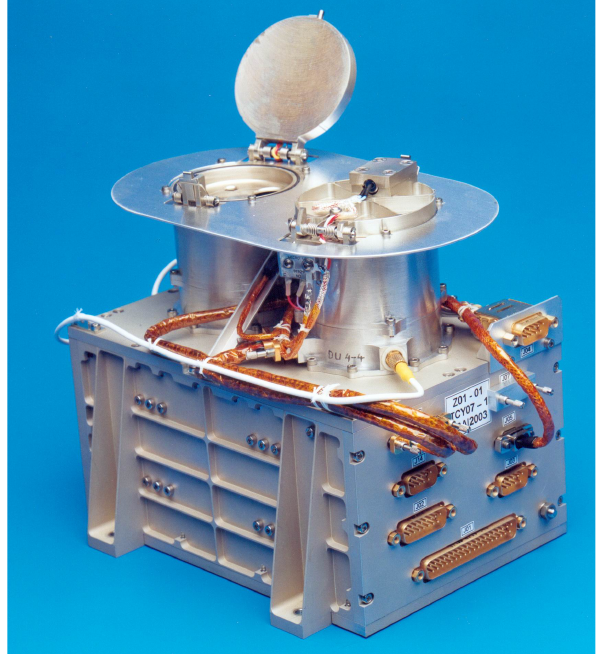
Fig. 4. The Double Star ASPOC unit.